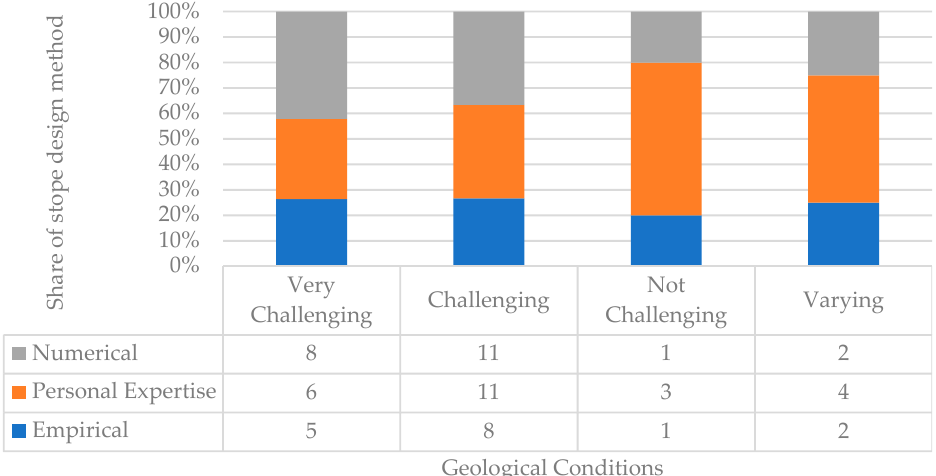
Figure 18. Correlation of geological conditions and the applied stope design method.